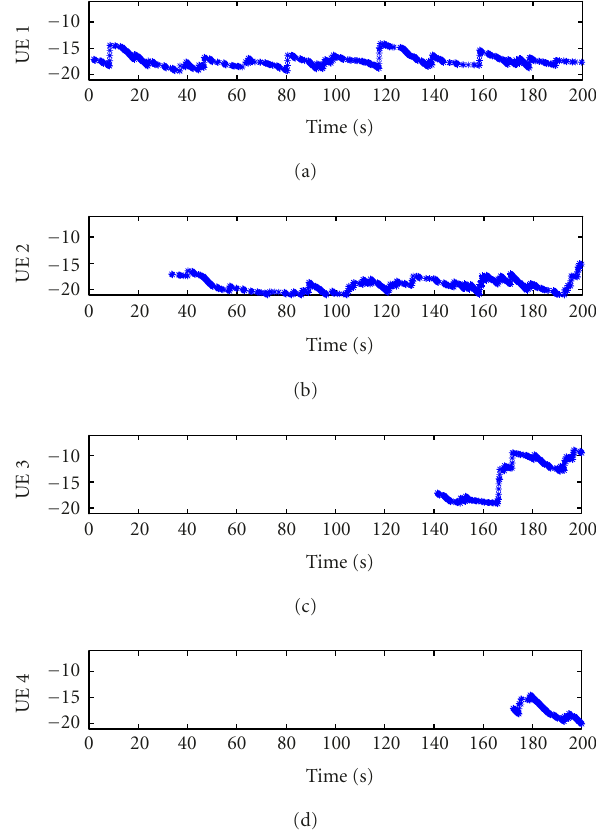
Figure 14: RNC (layer 3) target CIR commands with conventional